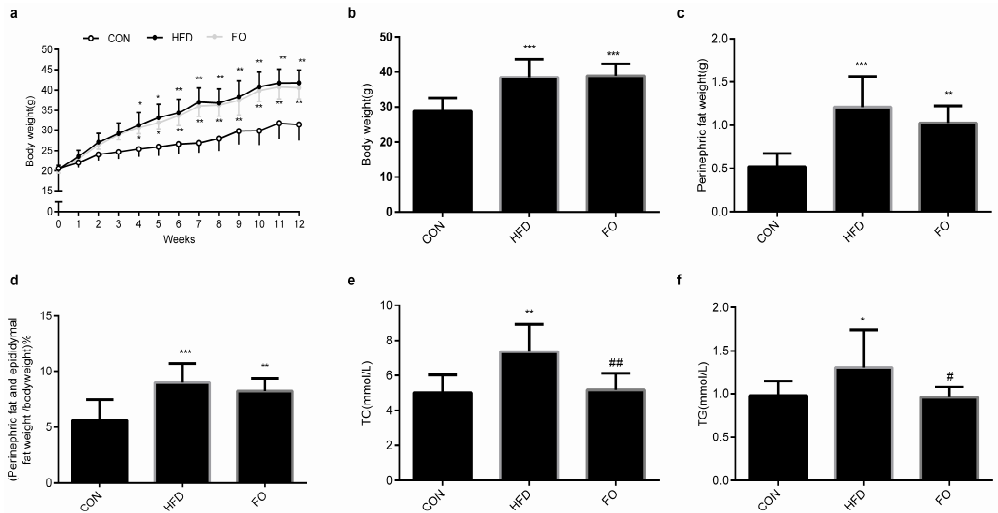
Figure 1. Phenotypic comparison of mice fed the control (CON), high fat diet (HFD), or fish oil (FO) diets for 12 weeks. ( a ) Body weight of mice at 12 weeks. At the end of week 12, the body weight of the three groups ( b ), perinephric fat weight ( c ), the perinephric and epididymal fat weight/body weight ratio ( d ), the plasma total cholesterol (TC) ( e ) and triacylglycerol (TG) ( f ). Data are expressed as mean ± SD ( n = 10 per group). * p < 0.05, ** p < 0.01, *** p < 0.001 vs. CON group; # p < 0.05, ## p < 0.01 vs. HFD group.